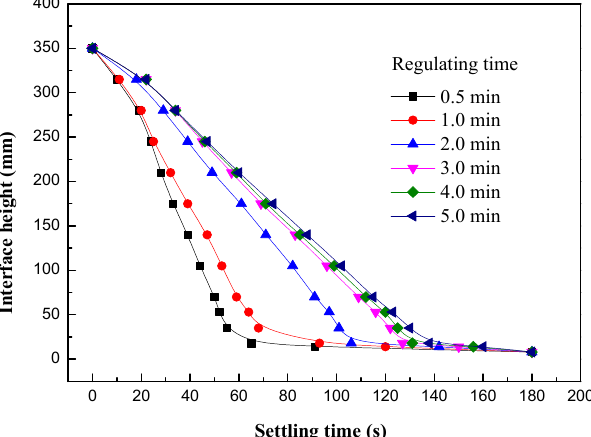
Figure 1. Effect of Fe 3+ dosage on the sedimentation (APAM: 2 mg/L, pH: 6–7, regulating time: 5 min).